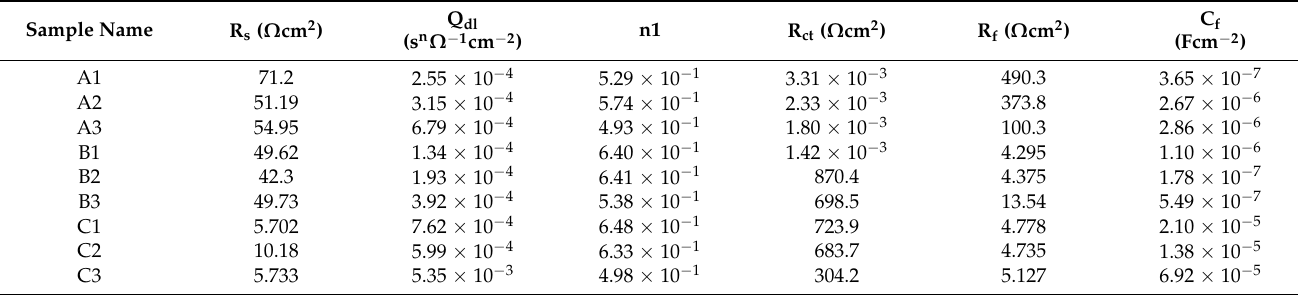
Figure 6. EIS equivalent circuit. Table 3. Fitting parameters of EIS of API 5L